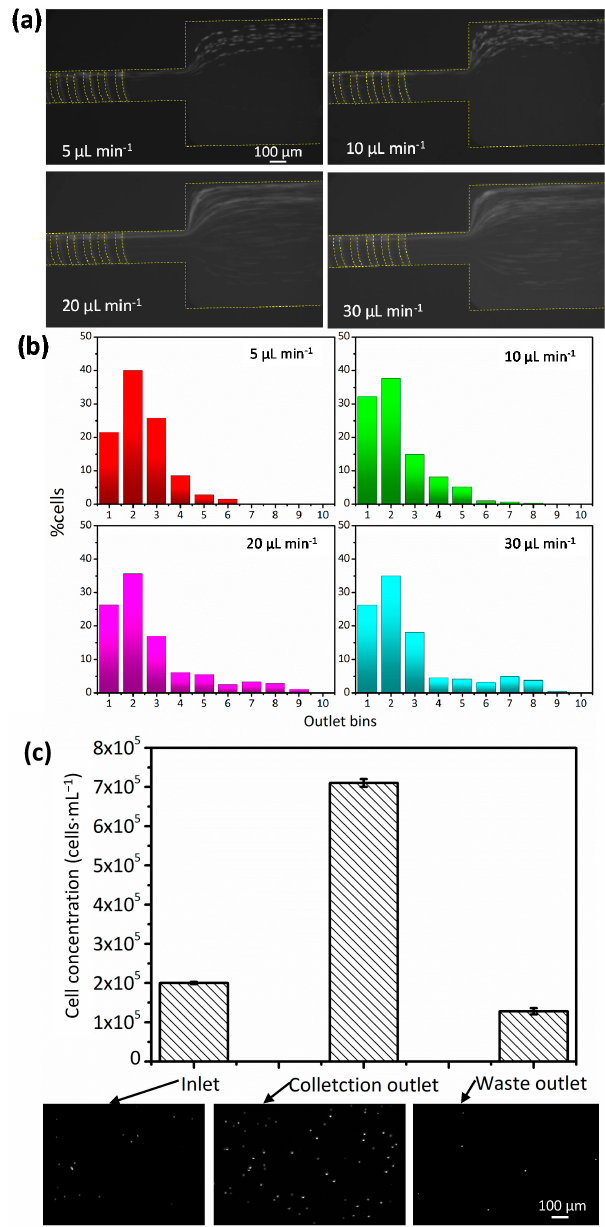
Figure 5. ( a ) Optical micrographs showing cell trajectories at the channel outlet at flow rates of 5, 10, 20, and 30 µL·min − 1 . The Jurkat cells were spiked into undiluted blood; ( b ) a plot of cell distribution at the channel outlet for varying flow rates where more than 500 cells were counted for each experiment; ( c ) the plot showing the concentration of cells collected from the inlet, collection outlet, and waste outlet. The average value was three times the measurement, and the error bar represents standard deviation. The fluorescence images show the Jurkat cells collected from the inlet, collection outlet, and waste outlet; these images were captured at 50× magnification.